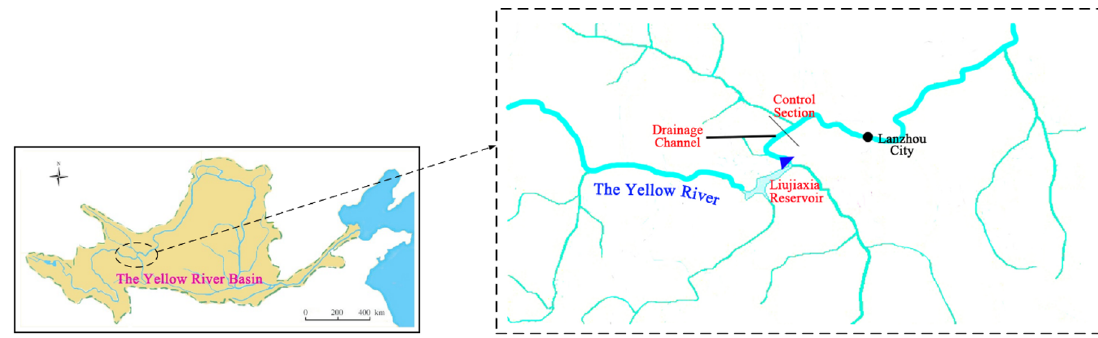
Figure 1. Watershed map of the Liujiaxia